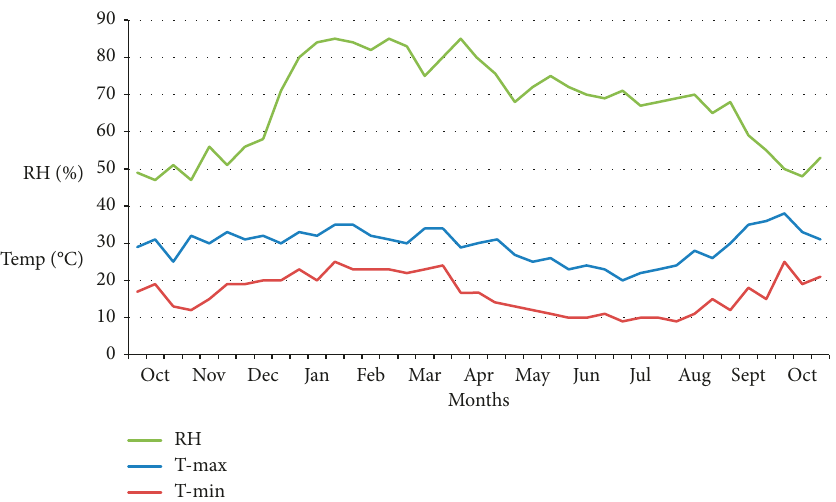
Figure 2: Relative humidity and temperature in the Northern Region, 2014-2015 season